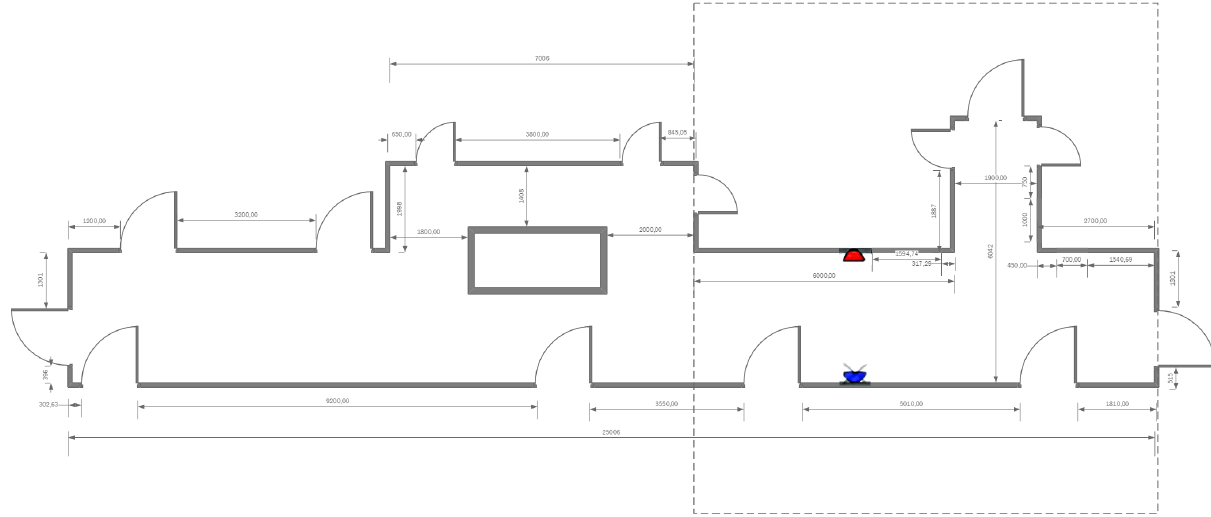
Figure 3. Original floor plan, taken from